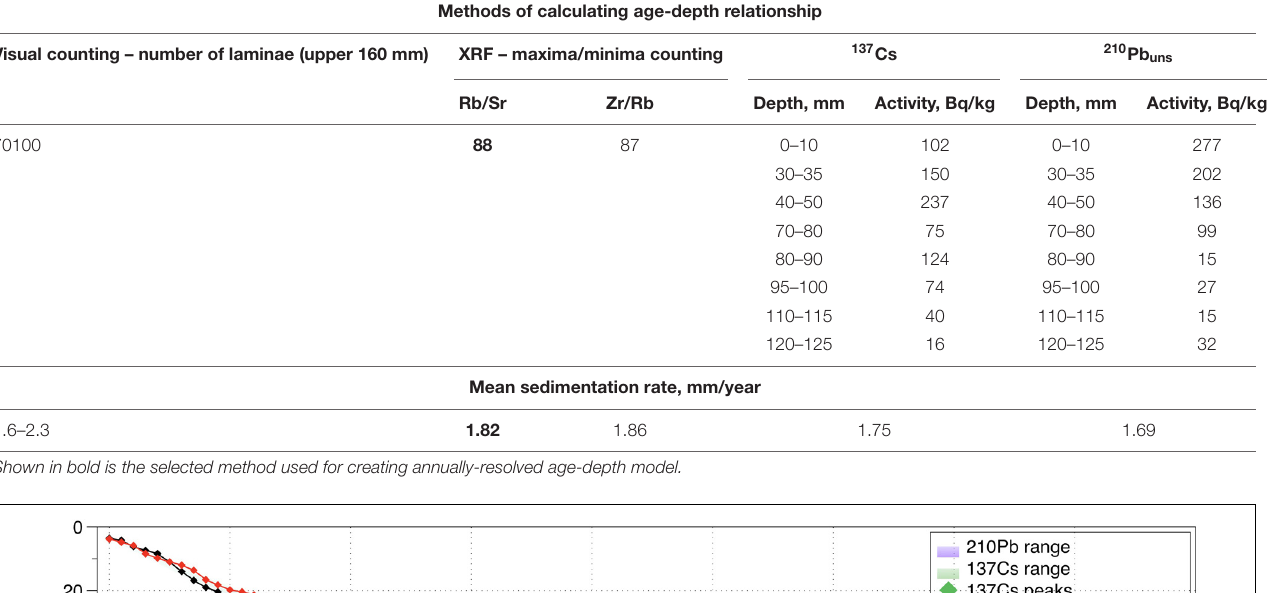
TABLE 1 | Mean sedimentation rates as calculated with the use of available techniques.